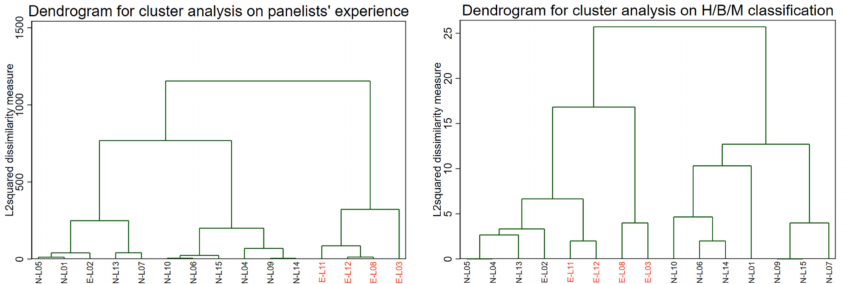
Figure 4. Left, dendrogram resulting after a cluster analysis on the variables synthesising the panellists’ experience; right, dendrogram resulting after a cluster analysis on the classification of lesions as hyperplasia, benign,